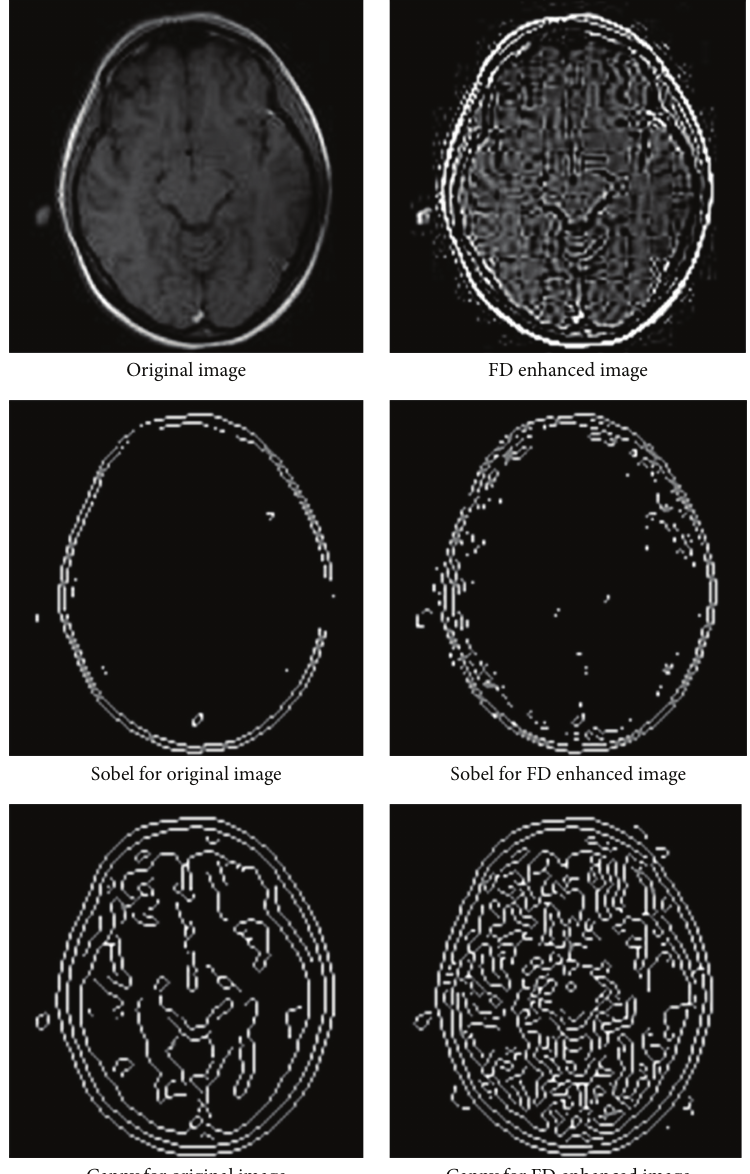
Figure 4: Results of the proposed enhancement algorithm by using FD masks for 𝜌 = 6 , 𝜇 = 0.05 , and 𝛼 = 0.9 . For digital images, the coefficients of 2D FD masks can be obtained in eight directions: 180 ∘ , 90 ∘ , 0 ∘ , 270 ∘ , 45 ∘ , 135 ∘ , 315 ∘ , and 225 ∘ (Figure 1). These masks are located on the negative 𝑦 -coordinate, negative 𝑥 -coordinate, positive 𝑦 -coordinate, positive 𝑥 -coordinate, left upward diagonal, right upward diagonal, left downward diagonal, and right downward diagonal, respectively. These masks are rotation invariant and are used to describe the textures and edges in